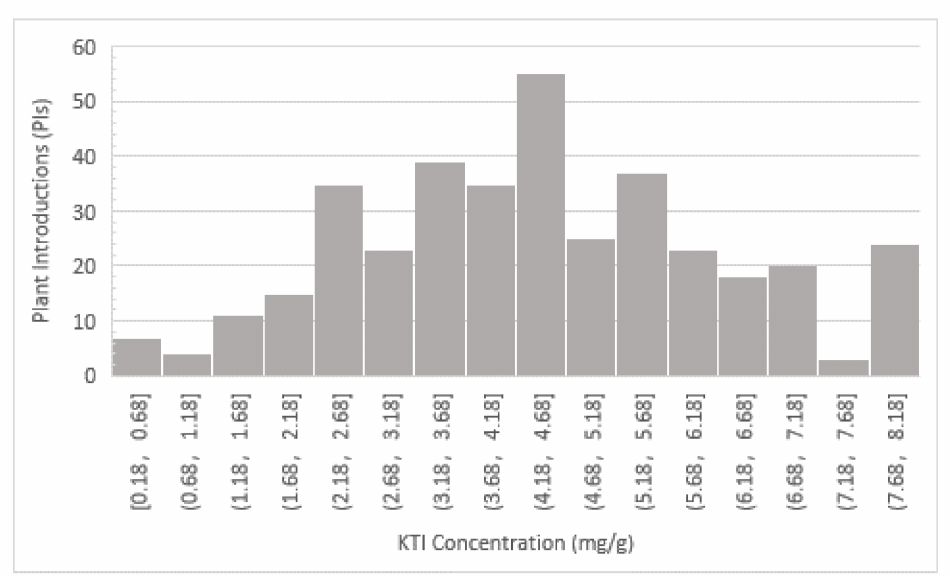
Figure 5. Frequency distribution of KTI concentration (mg/g) of 500 soybean accessions collected by the National Genetic Resources Program (USDA Soybean Germplasm